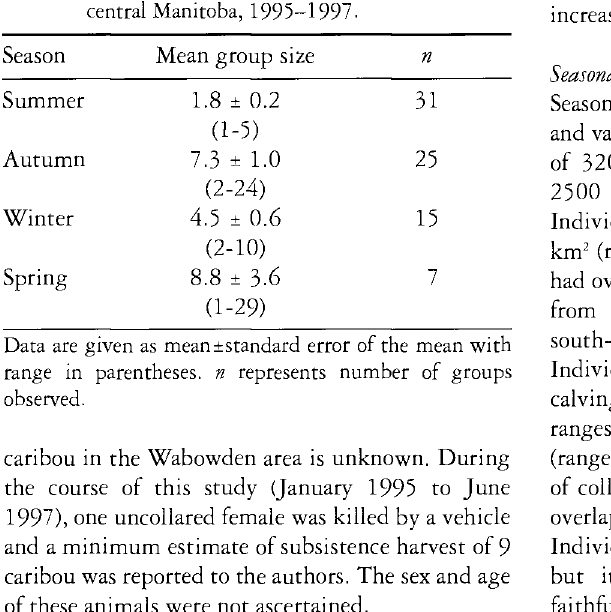
Table 1. Seasonal group size of woodland caribou in central Manitoba, 1995-1997.